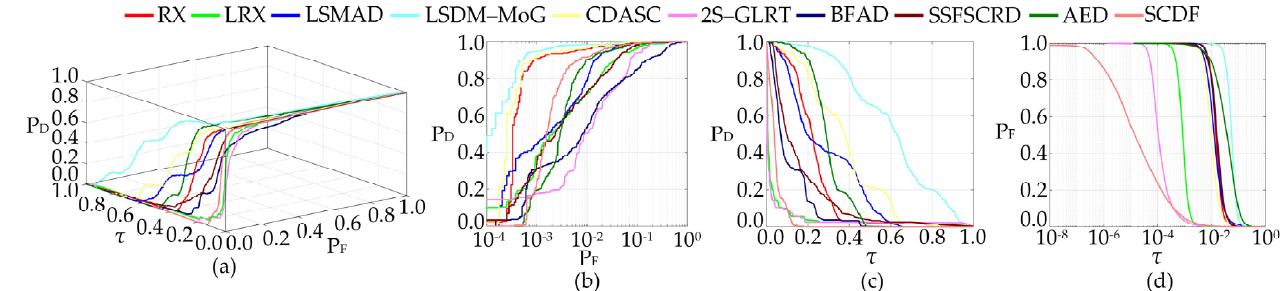
curve (P D , τ ); ( d ) corresponding 2D ROC curve (P F , τ ).